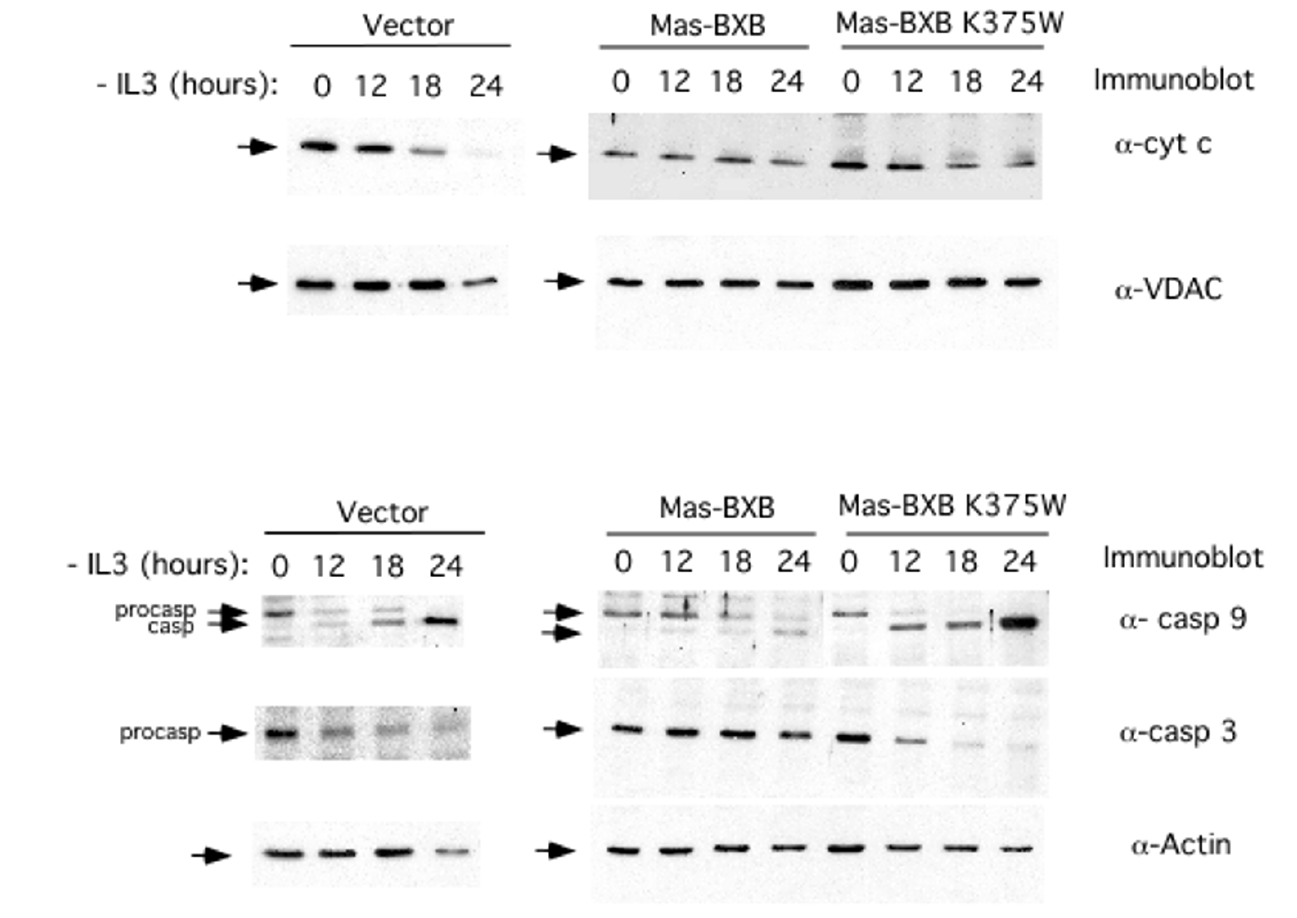
Figure 3 C-Raf inhibits the release of cytochrome c from mitochondria and caspases processing. 32Dcl.3 transfected cells were maintained without IL-3 for different time periods before isolating mitochondria and cytosol. Immunoblot analysis was performed on mito- chondrial extracts for the detection of cytochrome c release and on cytosol for the analysis of procaspases 3 and 9 cleavage. Blots were stripped and reprobed with anti-VDAC or anti-actin antibodies as protein loading